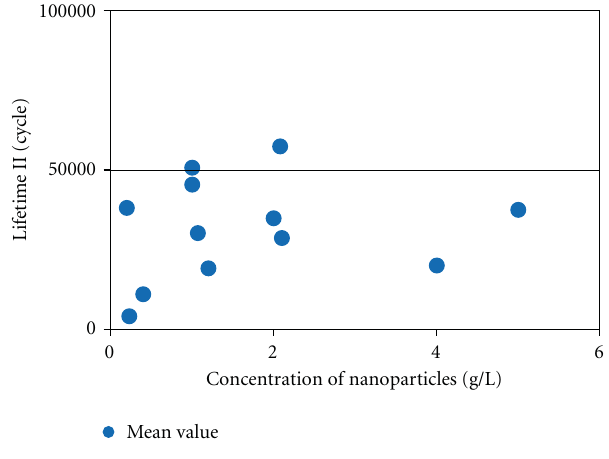
Figure 10: E ff ect of concentration of nanoscale particles in elec- trolyte (particles as powder).